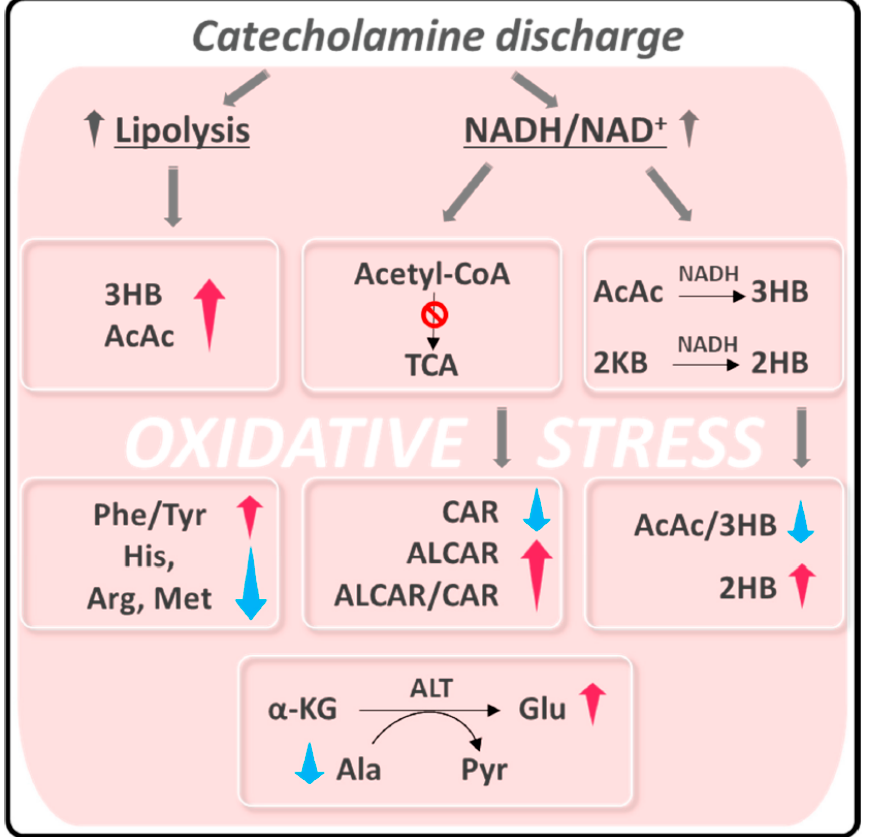
Figure 6. Summary of alteration observed in TTS patients related to oxidative stress. Abbreviation